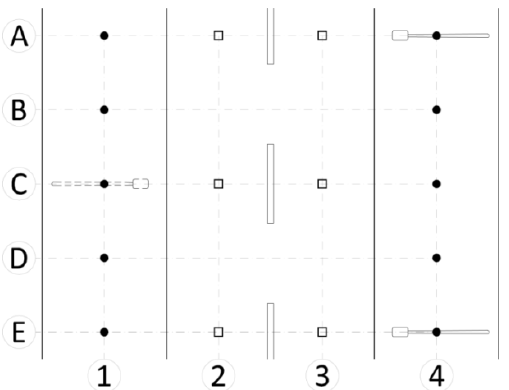
Figure 9. Grid adopted for measurements of illuminance and luminance values. The following symbols are used; ● (black dot): illuminance measurement point; □ (white square): luminance measurement point. Table 7. Results of the measurements survey for the 12 analysed roads (present status). The luminance